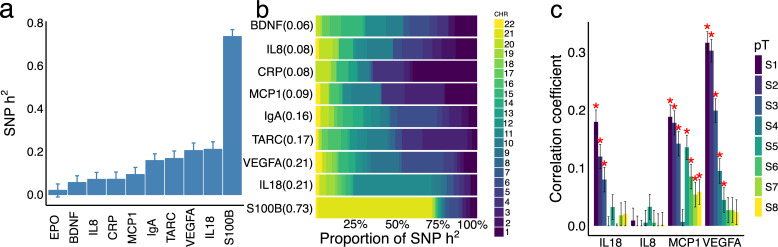
SNP heritability of circulating protein levels.The variation of circulating marker levels captured by a. all the genotyped SNP; b. SNPs on each autosome and c. polygenic scores computed from independent sample are shown. Cytokine SNP-heritabilities were shown in a by point estimates and standard errors. These point estimates were also shown in parentheses following the cytokine names on b. The Pearson’s correlation coefficients between polygenic scores and measured protein levels in the discovery sample are stratified by different p value thresholds (pT) of association in the discovery sample (S1, P<1x10-6; S2, P <1x10-5; S3,1x10-4; S4, P <0.001; S5, P < 0.01; S6, P < 0.1; S7, P <0.5; S8, P <1.0). The effect sizes used to compute polygenic scores are derived from Ahola-Olli et al.[17].